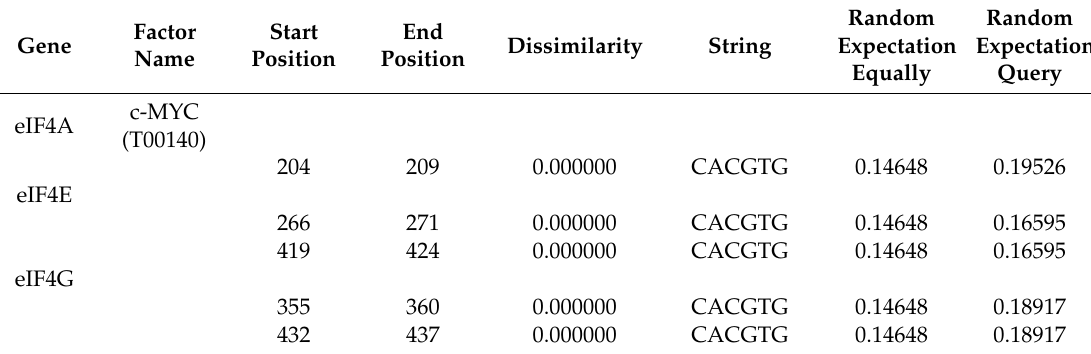
Table 3. c-MYC putative promoter binding